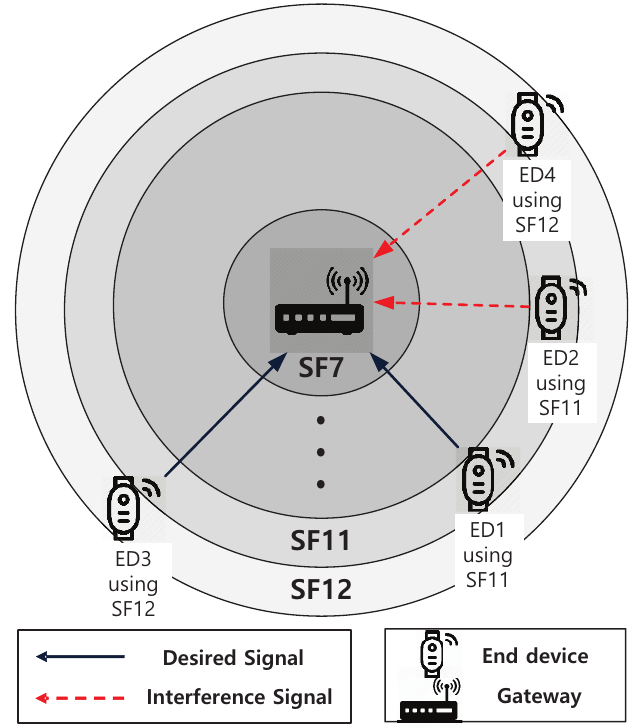
Figure 1. Long range (LoRa) network composed of the end devices (EDs) and the gateway, where the desired signal of ED1 only suffers from the interference signal of ED2 and the desired signal of ED3 only suffers from the interference signal of ED4 by using chirp spread spectrum (CSS). Table 1. LoRa Spreading factor versus Range and demodulator signal-to-interference noise ratio (SINR). Region Spreading Factor Range LoRa Demodulator SINR SF7 2 km − 7.5